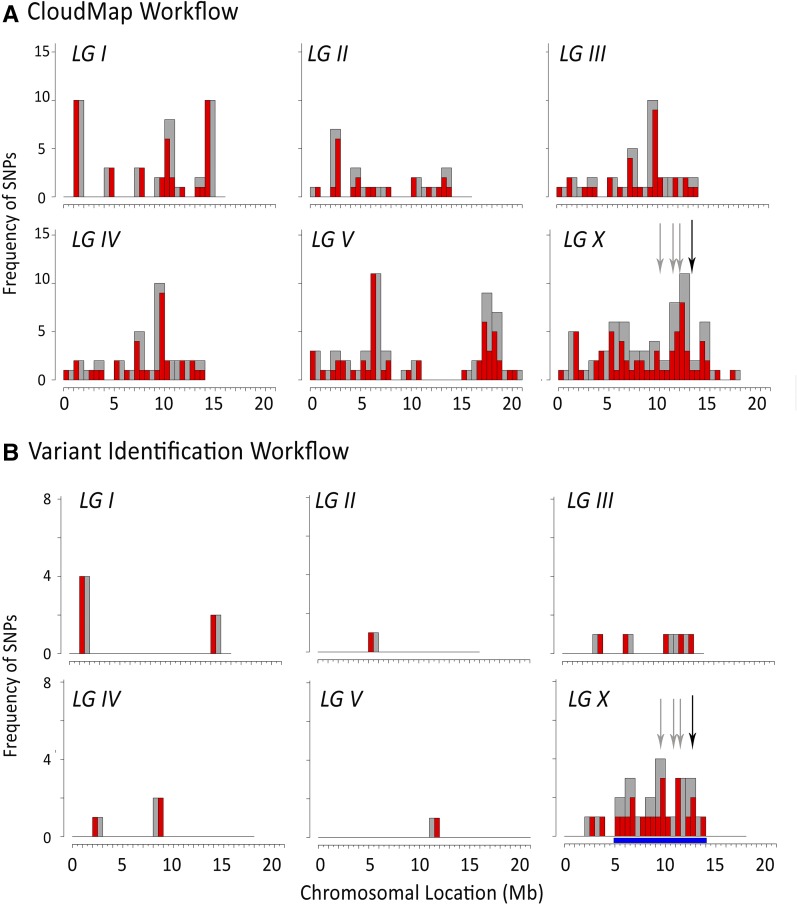
EMS density mapping comparison in WY1208. EMS density mapping for the five suppressor strains was carried out using the CloudMap workflow on Galaxy (A) or using our variant identification workflow based on allele frequencies (B). The x axis indicates the location on each chromosome in megabases (Mb). The number of EMS signature SNPs are indicated on the y axis; red bars indicate a 0.5-Mb region, and gray bars indicate a 1.0-Mb region. Black arrows indicate the location of the identified causal mutations, and gray arrows indicate noncausal mutations identified by SSM. The blue bar in (B) indicates the implicated region on LGX that contained five coding-change candidates.